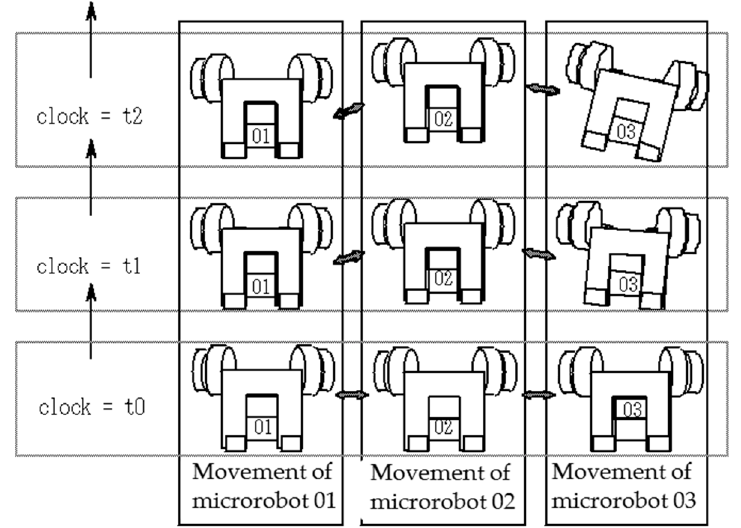
Figure 8. Image of multiple connected movement. First, by focusing on the motion of each individual microrobot, as the simulation time progresses from t0 to t1 to t2, the respective position of each microrobot will change based on the applied rotational speed, acting gravity, and wheel magnetic attraction force.